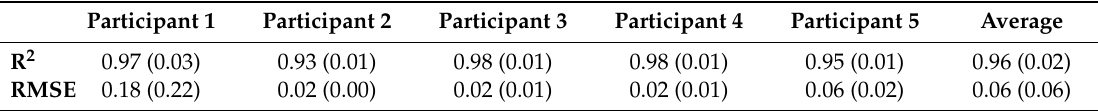
Table 2. Coefficient of determination (R 2 ) and root mean squared error (RMSE) of predicted RPE level with standard deviations.